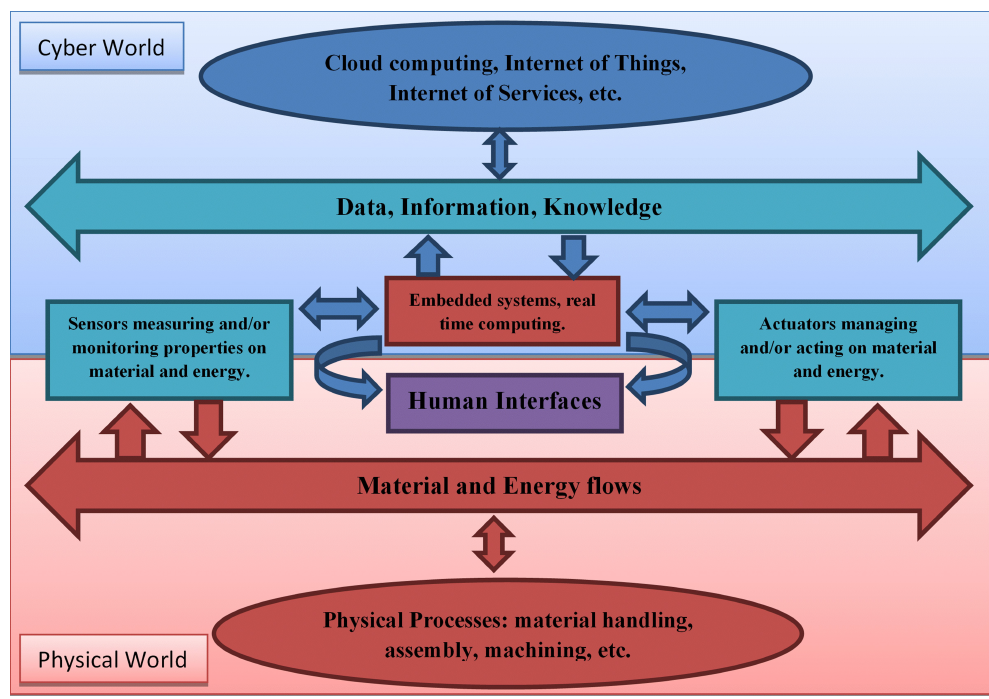
Figure 1. Cyber-physical system